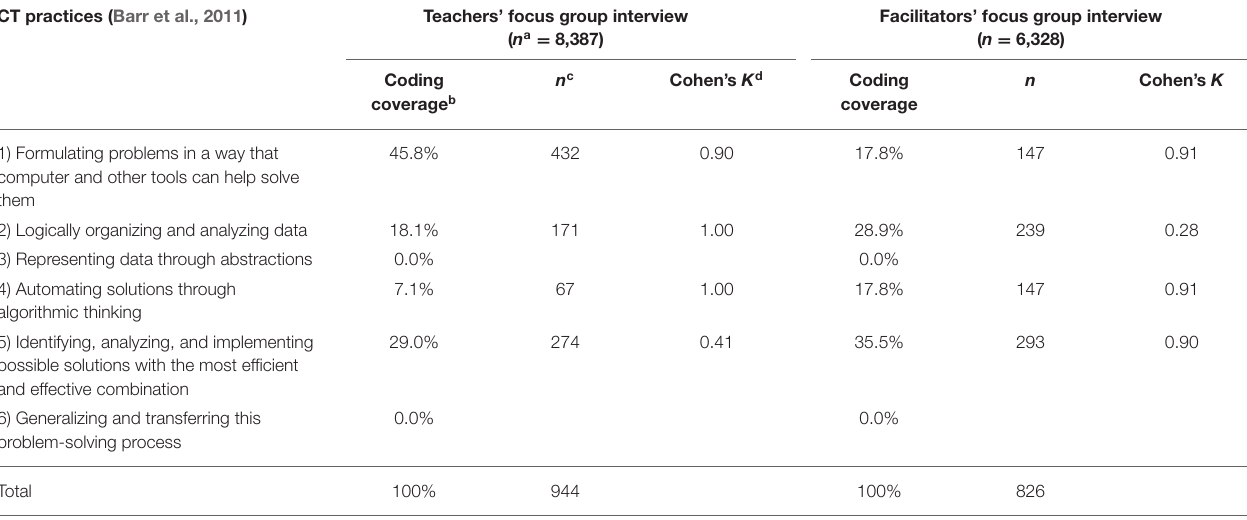
TABLE 5 | Summary of the aspects of CT practices identified in focus group interviews (developed based on Iwata et al., 2019). CT practices (Barr et al.,